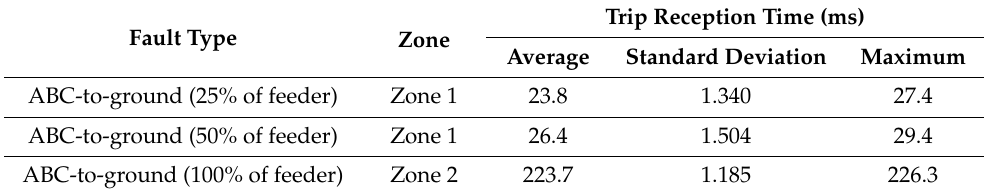
Table 2. Fault injection tests for MP1 in bay 2.